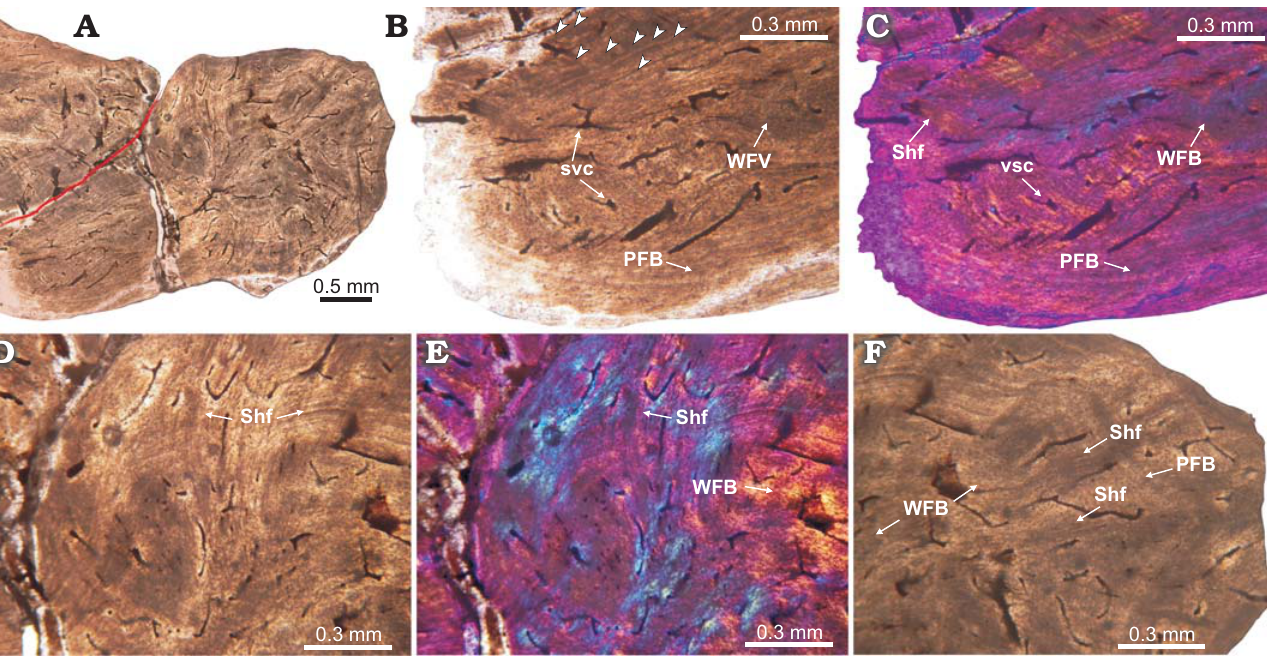
Fig. 7. Histology of proterochampsid Chanaresuchus bonapartei Romer, 1971, PULR 07 osteoderm from La Rioja province, Ladinian–Carnian. A . Com- plete longitudinal section view. Note the poorly vascularization. Red line indicates separation between the complete osteoderm and the rest of another. B , C . Detail of basal cortex. It is constituted in the outermost cortex by parallel-fibered bone and toward the interior of osteoderm, it acquires the features of woven-fibered bone. Multiple growth marks and some Sharpey fibers are observed. D , E . View of the upper portion of osteoderm. The abundance of Sharpey fibers prevents clear observance of the bone matrix, which appears to be parallel-fibered bone. Some LAGs can be tracked also. F . Detail of the marginal region. It is formed in its outer region by lamellar bone and in the perimedular portion by woven-fibered bone. Large and dense bundles of Sharpey fibers are observed. Some LAGs are also present. Arrowheads point to growth marks (LAGs). A, B, D, F, normal light; C, E, cross-polarized light with lambda compensator. Abbreviations: PFB, parallel-fibered bone; Shf, Sharpey fibers; svc, simple vascular canal; WFB, woven-fibered